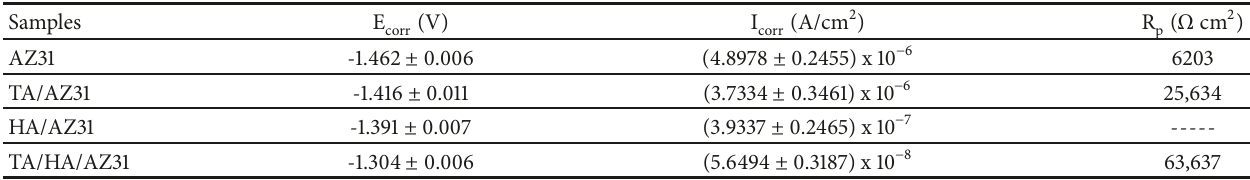
Table 4: The polarization resistance (R p ), corrosion potential (E corr ), and corrosion current density (I corr ) of the AZ31, TA/AZ31, HA/AZ31, and TA/HA/AZ31 samples in SBF at 37 ∘ C